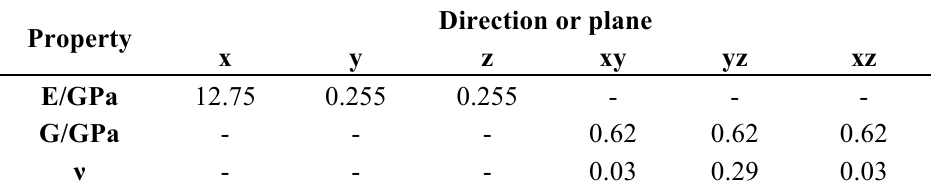
Table 1. Elastic properties of Kerto S laminated veneer